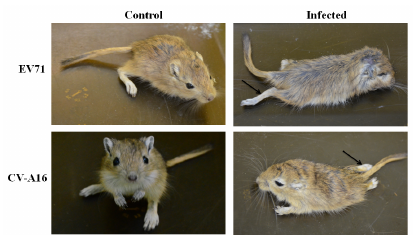
Figure 1. EV71- and CVA16-infected gerbils. At 21 days old, gerbils were infected with 100 × LD 50 of EV71 virus (1 × 10 4.6 TCID 50 ) and CVA16 virus (3.2 × 10 3.0 TCID 50 ). PBS was used as a negative control. Four days post-infection, pictures were taken, and the arrows indicate the limb paralysis of infected gerbils.